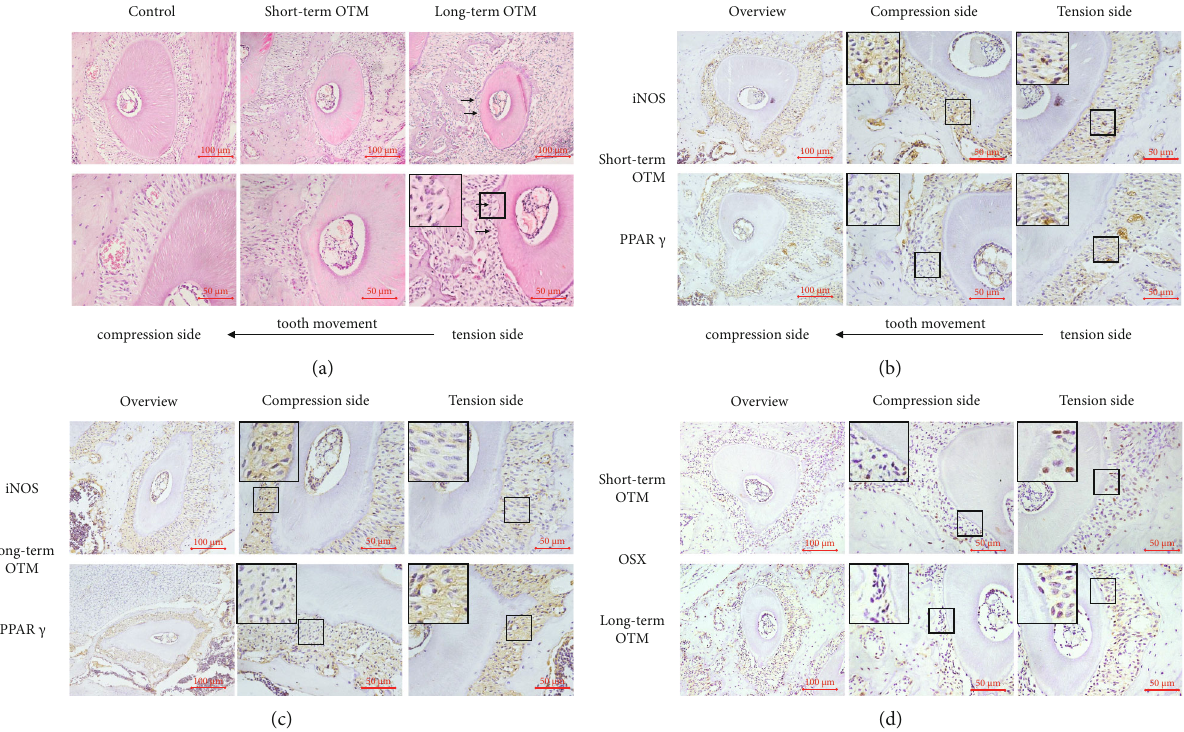
Figure 6: Root resorption, M1/M2 accumulation, and cementoblast mineralization in the mechanical force-induced OTM model. (a) Representative images of HE staining in the roots of the maxillary fi rst molar on the control side and in the short-term OTM (1 d) and long-term OTM (7 d) groups. Black arrows indicate the root resorption zone. Scale bars: 100 μ m/50 μ m. (b, c) Representative immunohistochemical images of iNOS and PPAR γ in the compression side and the tension side of right maxillary fi rst molar roots in the short-term OTM (1 d) and long-term OTM (7 d) groups. Scale bars: 100 μ m/50 μ m. (d) Representative immunohistochemical images of OSX on the compression side and the tension side of right maxillary fi rst molar roots in the short-term OTM (1 d) and long-term OTM (7 d) groups. Scale bars: 100 μ m/50 μ